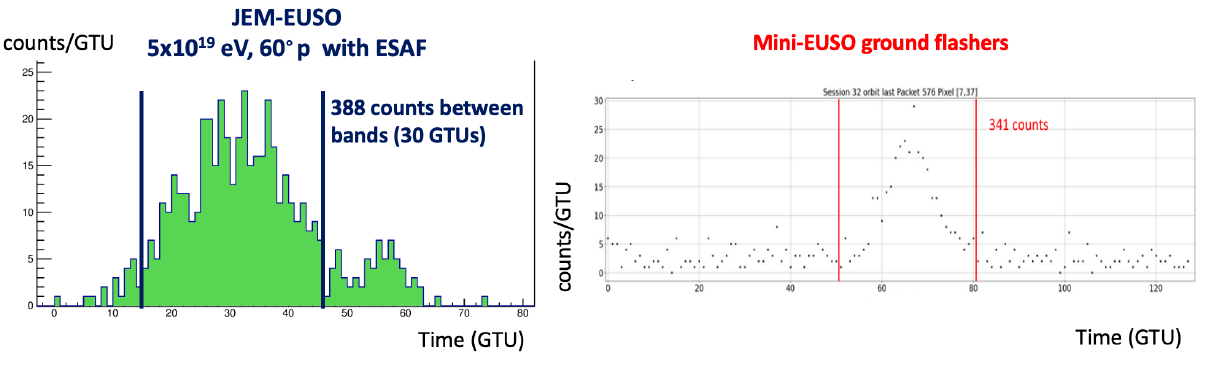
Figure 7. Left panel: a light curve of a simulated proton EAS of 5 × 10 19 eV with a 60 ◦ zenith angle as expected to be seen by JEM- EUSO (image adapted from [15]). Right side: a light curve of a single flash of a repetitive flasher signal detected by Mini-EUSO near the Missoula city in Michigan, US.